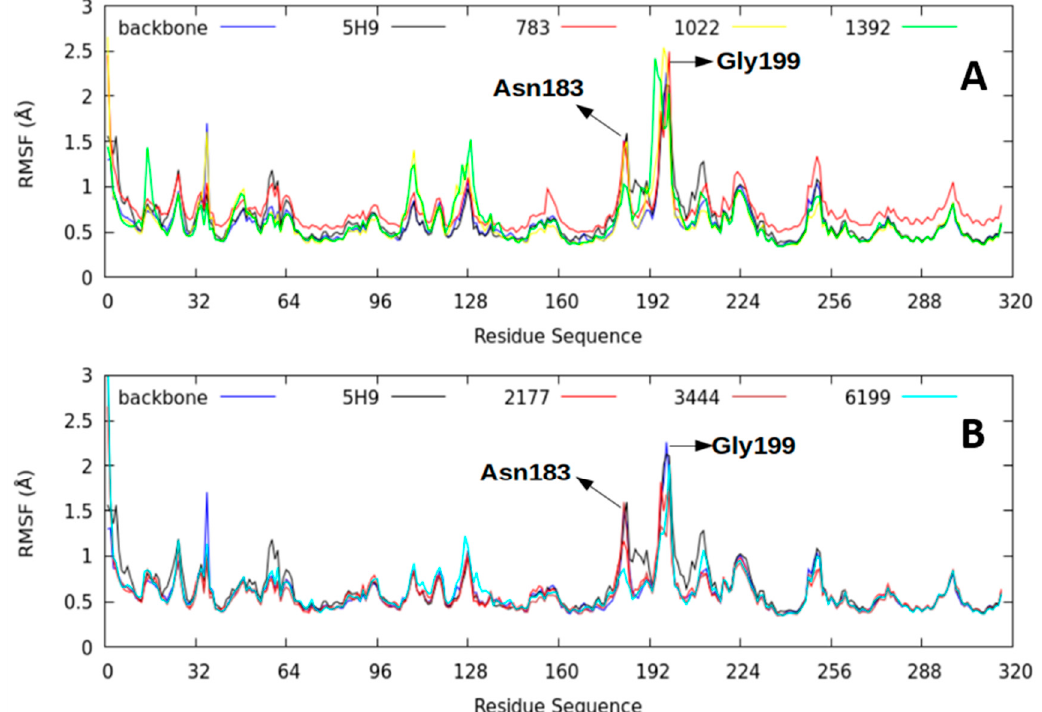
Figure 8. The ligand-thermolysin complexes’ backbone atoms’ root mean square fluctuation of molecular dynamics simulations (50 ns) at 298.15 K. ( A ) is the comparison between the Thermolysin backbone and the ligands Lig5H9, our reference compound, Lig783, Lig1022 and Lig1392. ( B ) is the comparison between the Thermolysin backbone and the ligands Lig5H9, our reference compound, Lig2177, Lig3444 and Lig6199.